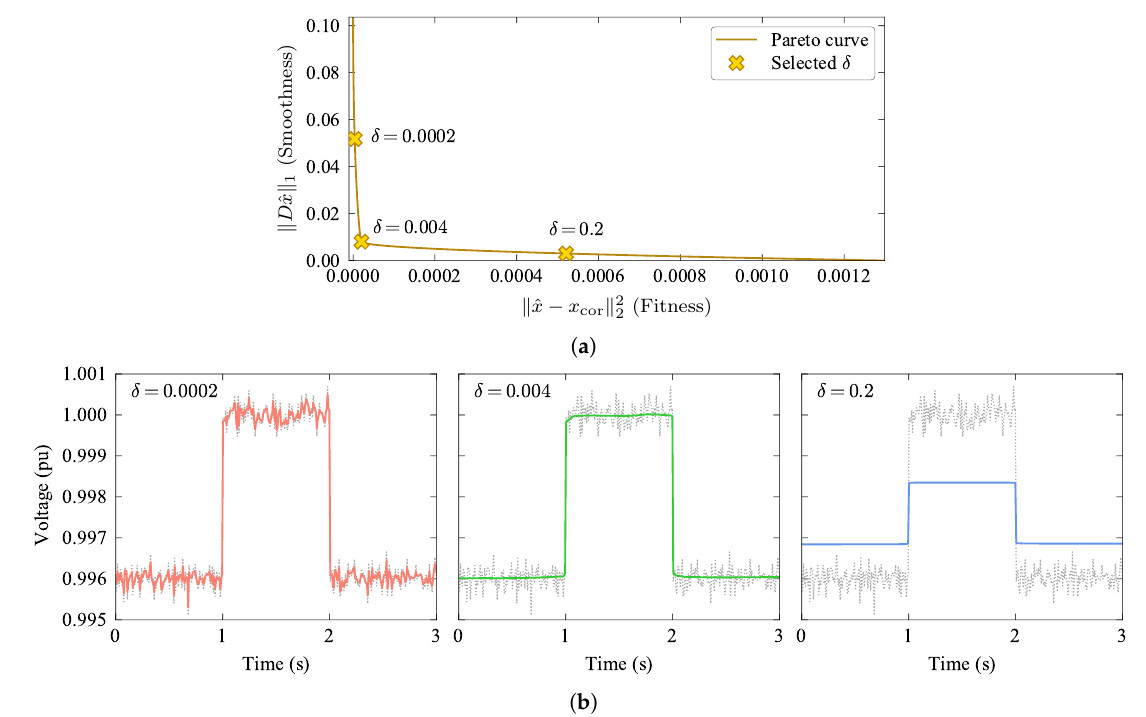
Figure 9. Results of filtering the corrupted synthetic signal 1 through total variation smoothing. ( a ) Pareto curve. ( b ) Estimated signals representing under-filtering ( δ = 0.0002), optimal filtering ( δ = 0.004) and over-filtering ( δ =